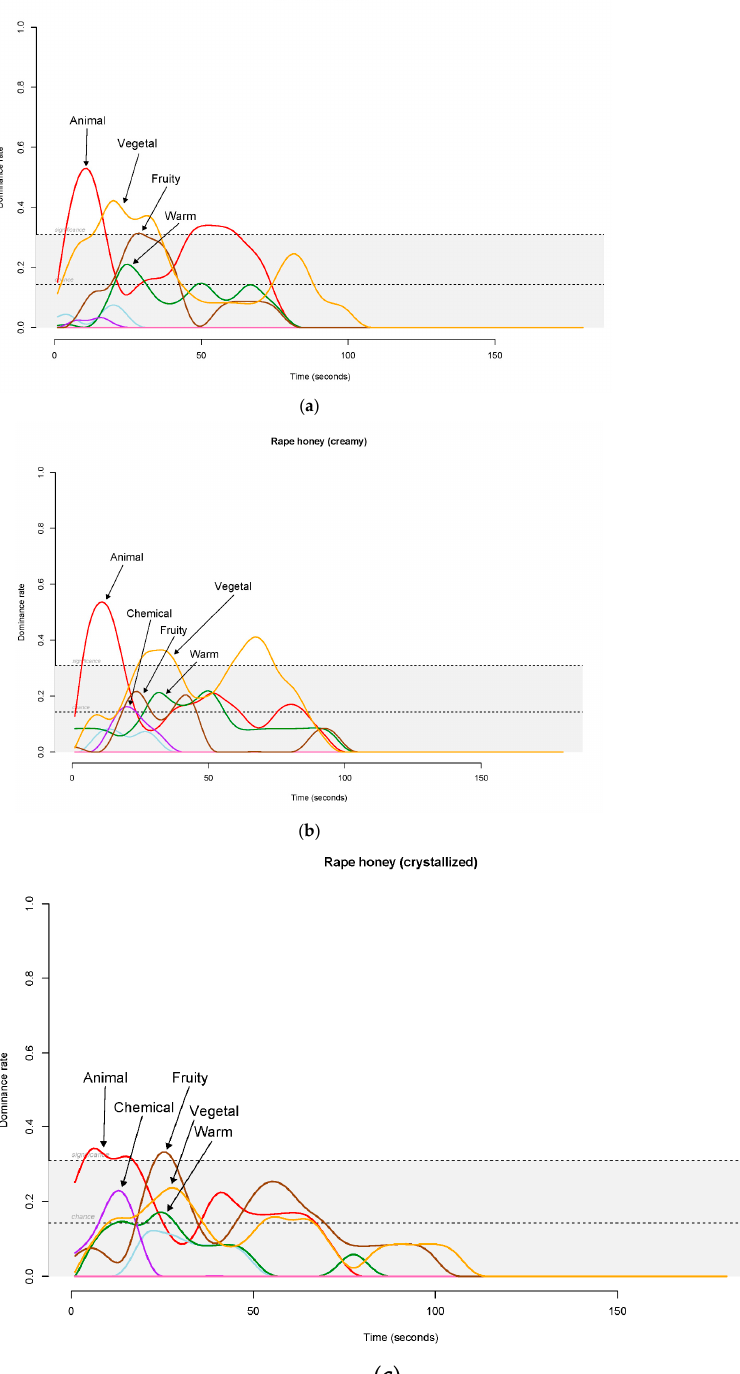
Figure 6. ( a ) TDS graphical representation for the liquid rape honey. For each attribute, the spline regression plot displays the nonlinear regression function plotted through the original data. ( b ) TDS graphical representation for the creamy rape honey. For each attribute, the spline regression plot displays the nonlinear regression function plotted through the original data. ( c ) TDS graphical representation for the crystallized rape honey. For each attribute, the spline regression plot displays the nonlinear regression function plotted through the original data.